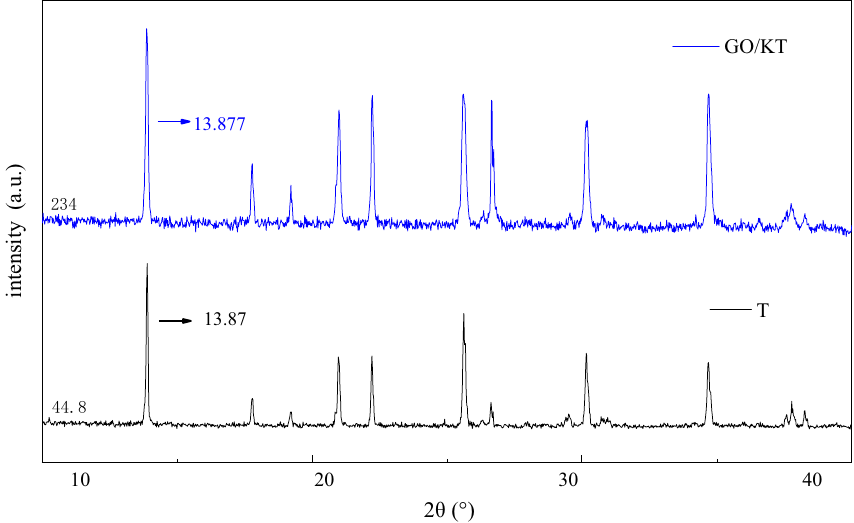
Figure 10: XRD pattern of GO/KT composites and